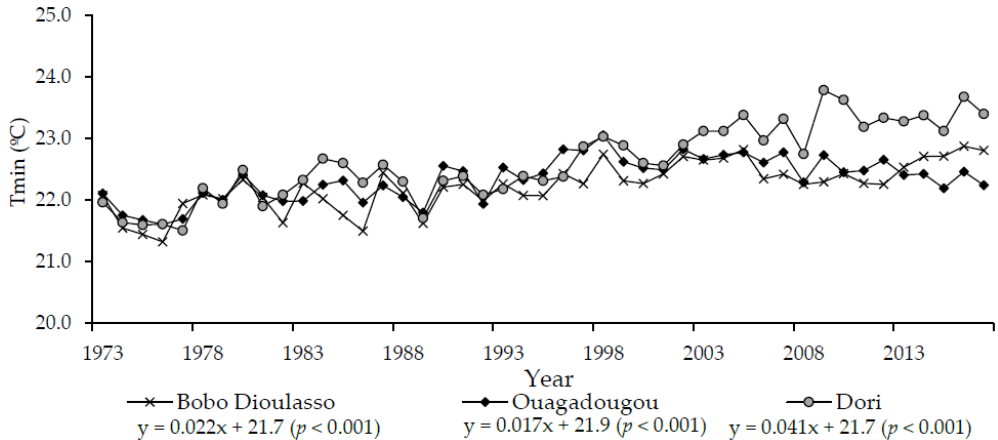
Figure 3. Mean annual minimum temperature (Tmin), lineal regression, and statistical significance along the different agroclimatic zones (Soudanian, Soudano-Sahelian, and Sahelian) for the period 1973–2017.